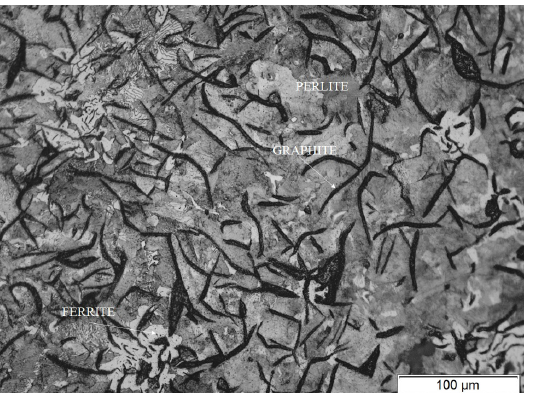
Figure 18. Matrix for Cr/Mo addition.